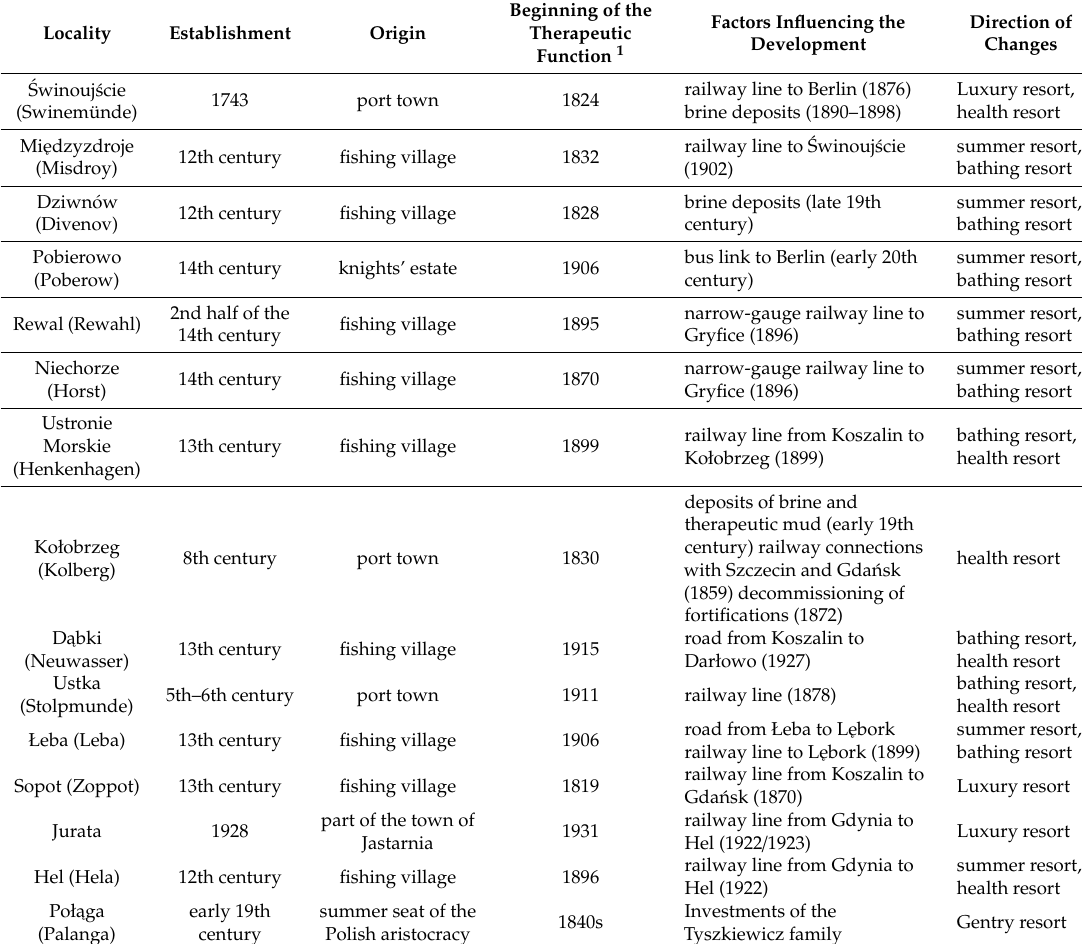
Table 1. Genesis and direction of transformations of selected seaside resorts. Source: Authors’